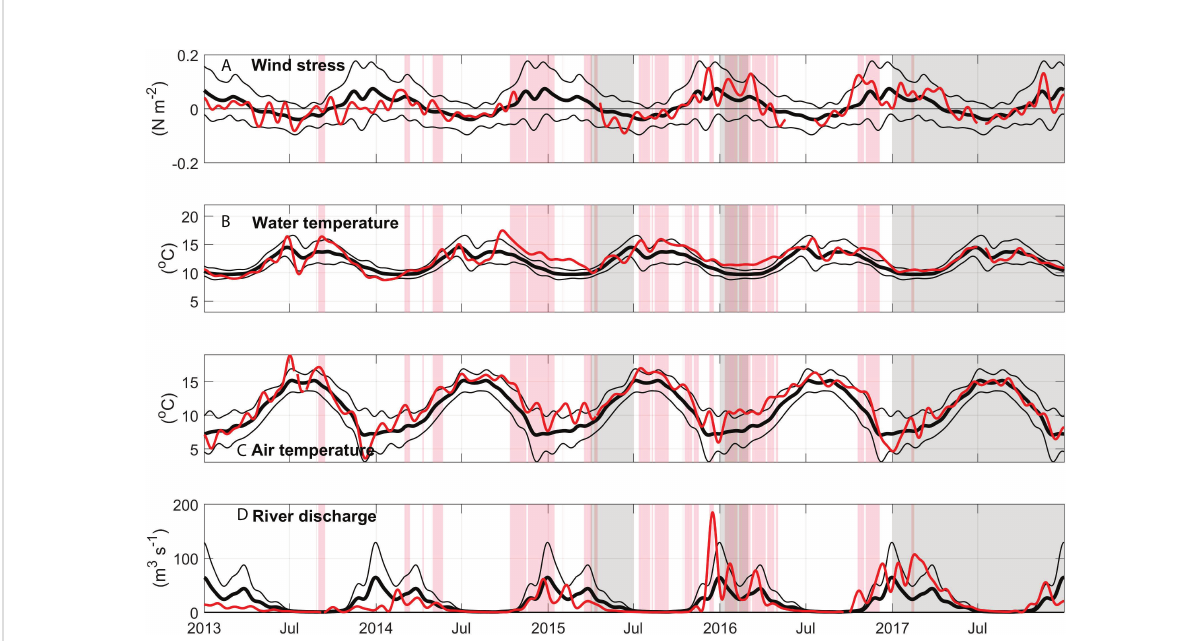
FIGURE 4 Environmental conditions outside the estuary during 2013-2017. (A) Daily averages with a 30-day low pass fi lter of North-South wind stress (N m -2 ) from the North Bend Airport meteorological station (red lines) showing 2004-2014 climatological mean calculated for 2004-2014 (thick black lines), thin black lines show ±1 standard deviation. Vertical red bands show periods in which water temperature at Charleston WQ is 1 standard deviation above the 2004-2014 climatology (Figure 6). Vertical gray bands show periods in which eelgrass density at Valino is at least 1 standard deviation below the 2004-2014 climatology. (B) same as (A) but for surface water temperature (°C) at the Stonewall buoy, (C) same as (A) but for air temperature (°C) at the North Bend Airport meteorological station, (D) same as (A) but for South Fork Coos River discharge (m 3 s -1